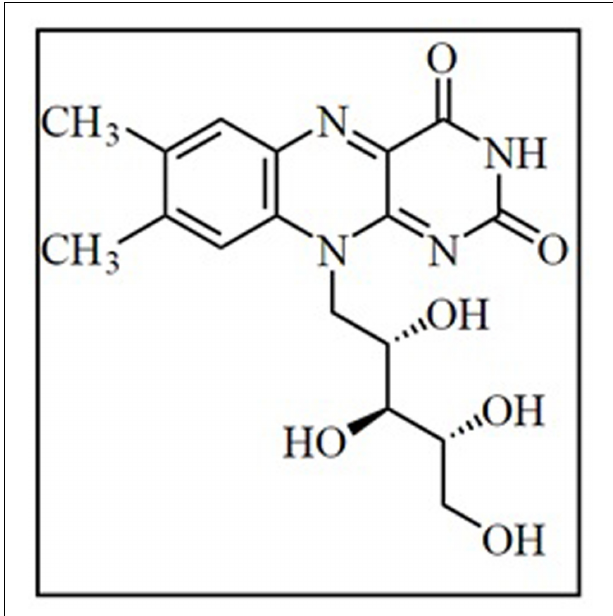
FIGURE 3 | Structure of riboflavin.